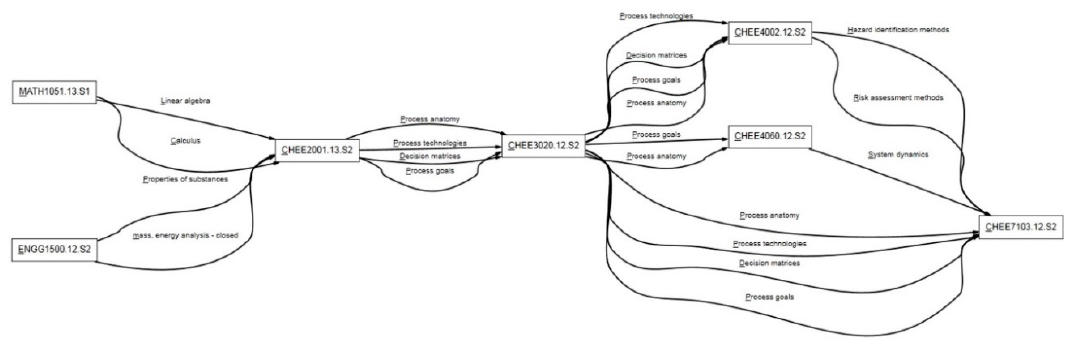
Figure 7. Example of knowledge domain outcome linkages for process system courses. (By permission of Engineers Australia [17]).